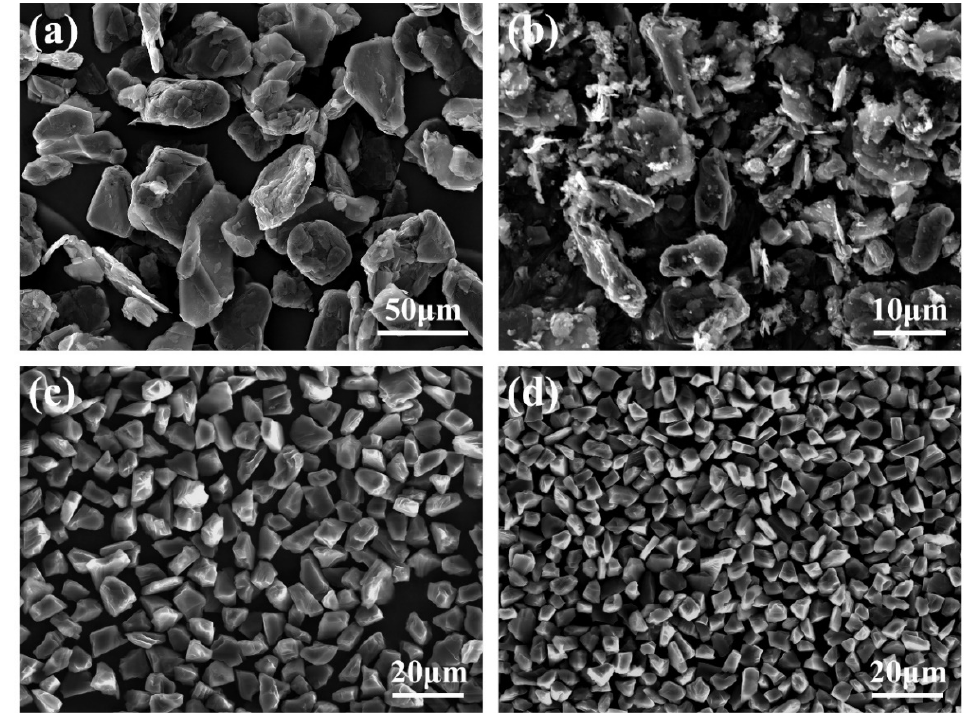
Figure 1. Microstructures of the used carbon sources: ( a ) 30 μ m graphite, ( b ) 4 μ m graphite, ( c ) 10 μ m diamond, and ( d ) 6 μ m diamond.